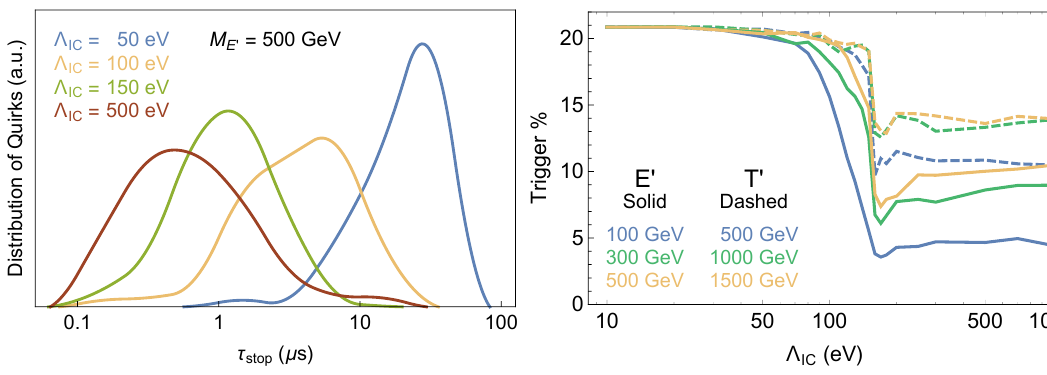
Figure 4 . Left: Distribution of the time for E 0 -like quirks at 500 GeV to stop within the CMS (cid:12)ducial region for several quirk con(cid:12)nement scales. For con(cid:12)nement scales above about 300 eV, the distribution does not change appreciably with increasing con(cid:12)nement scale. Decreasing the con(cid:12)nement scale once terminal velocities are achieved (see section 2) decreases the terminal velocity greatly, thus increasing the time to stop. The time to annihilate after stopping is conservatively assumed to be much quicker. Right: Probability for quirks that stop in the CMS (cid:12)ducial